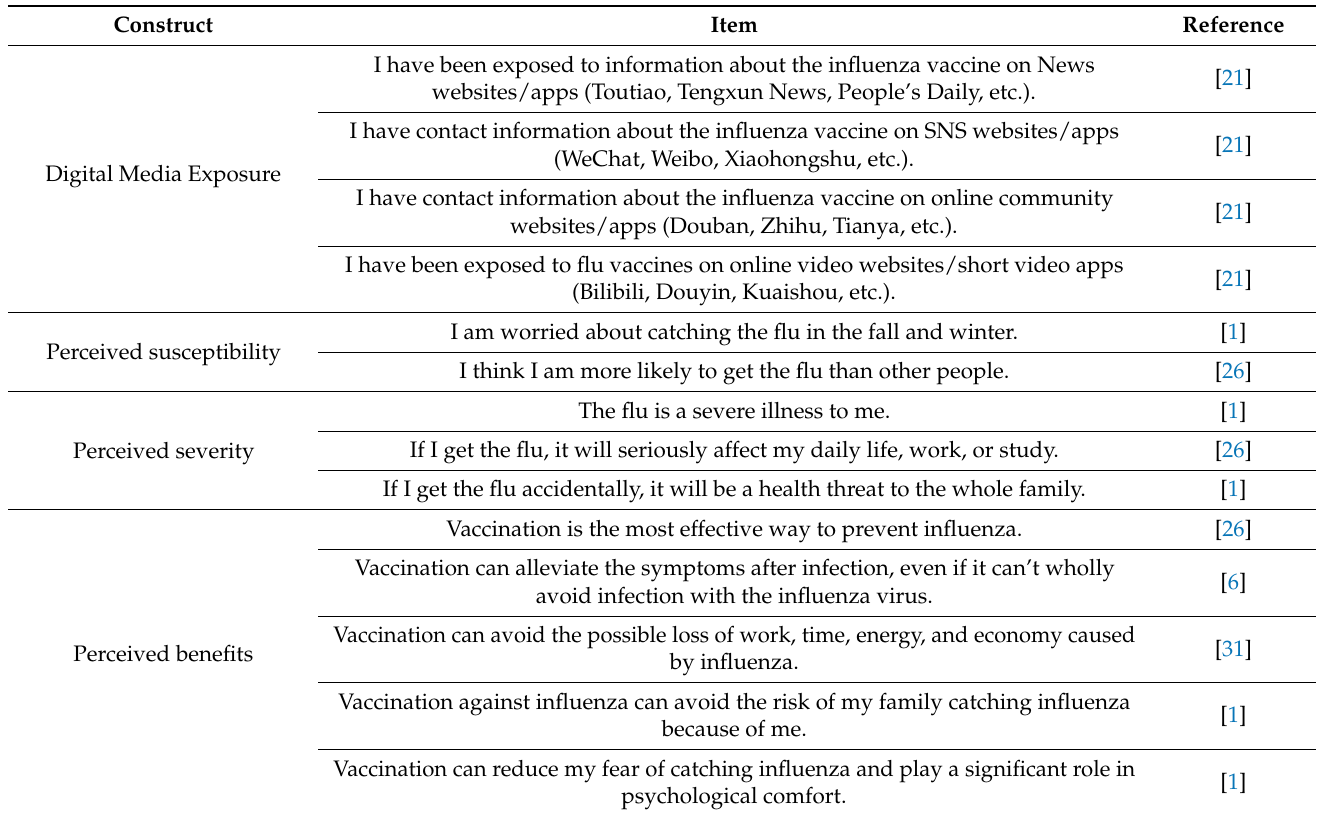
Table 1. Constructs and items included in the